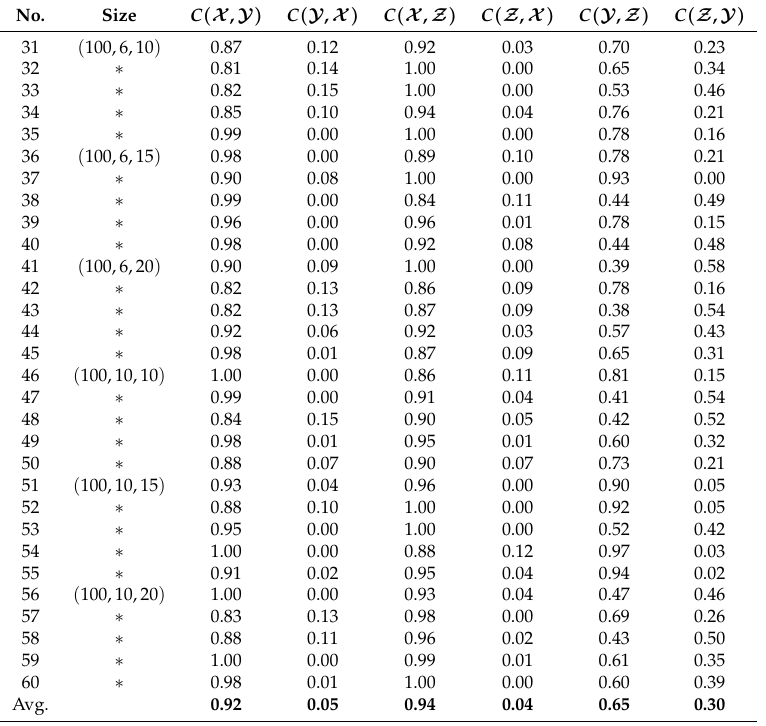
Table 9. Coverage metrics for comparing the algorithms on the test instances with 100 cars.